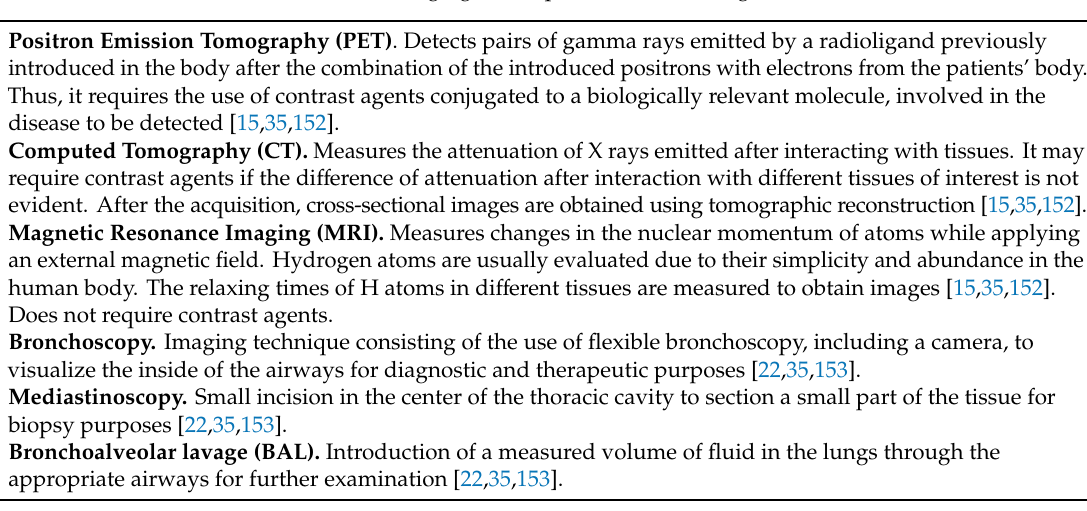
Table A1. Imaging techniques for NSCLC diagnosis.